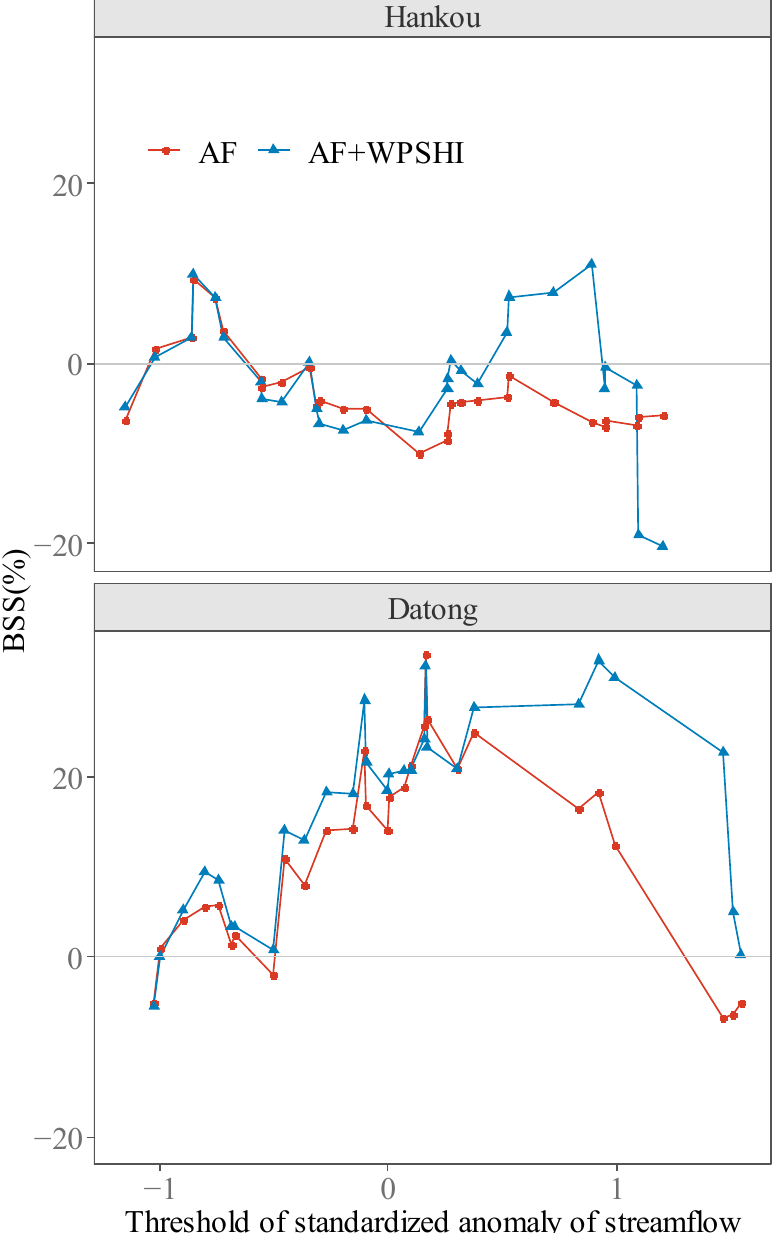
Figure 11. BSS by the RAN approach for summer streamflow of Hankou and Datong, corresponding to the forecast of CFSv2 released in May.